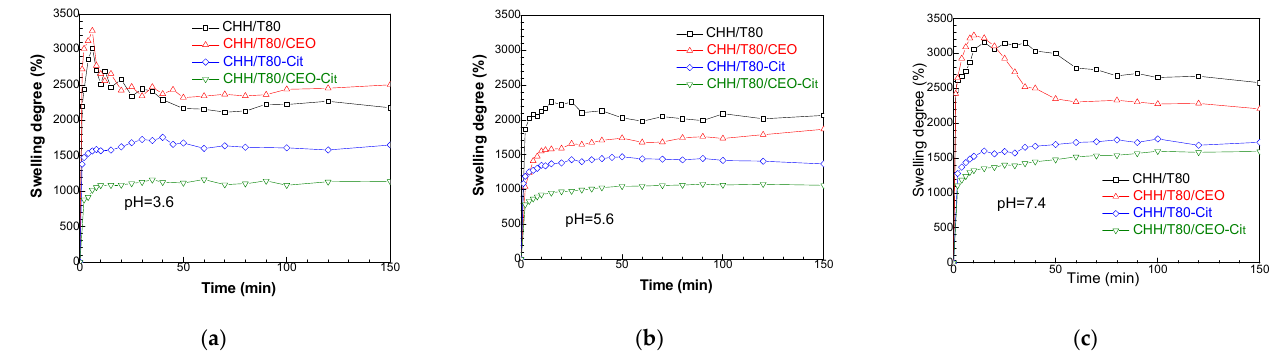
Figure 10. Swelling behavior of chitosan-based hydrogels (CHH/T80), citrate cross-linked (CHH/T80-Cit) and loaded with clove essential oil (CHH/T80/CEO) in various media of pH 3.6 ( a ), pH 5.6 ( b ) and pH 7.4 ( c ). and pH 7.4 ( c